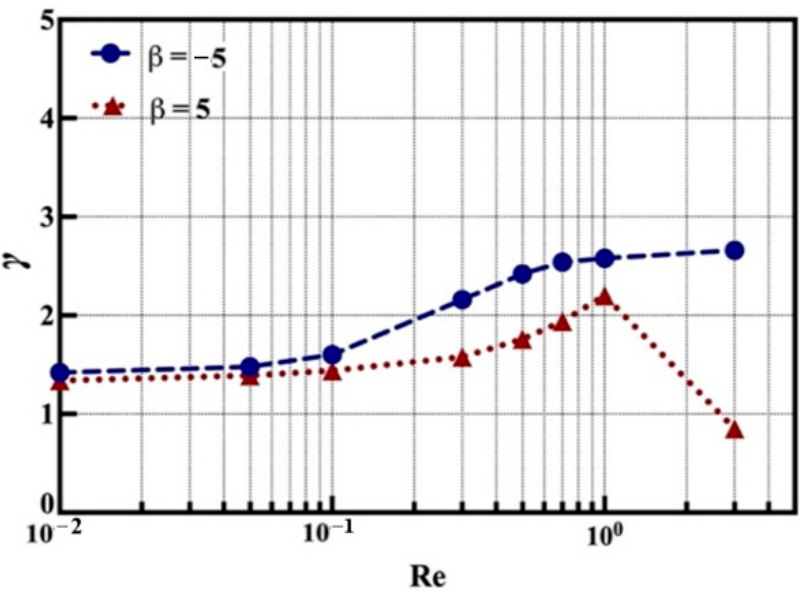
Figure 11. Relationship between γ and Re.